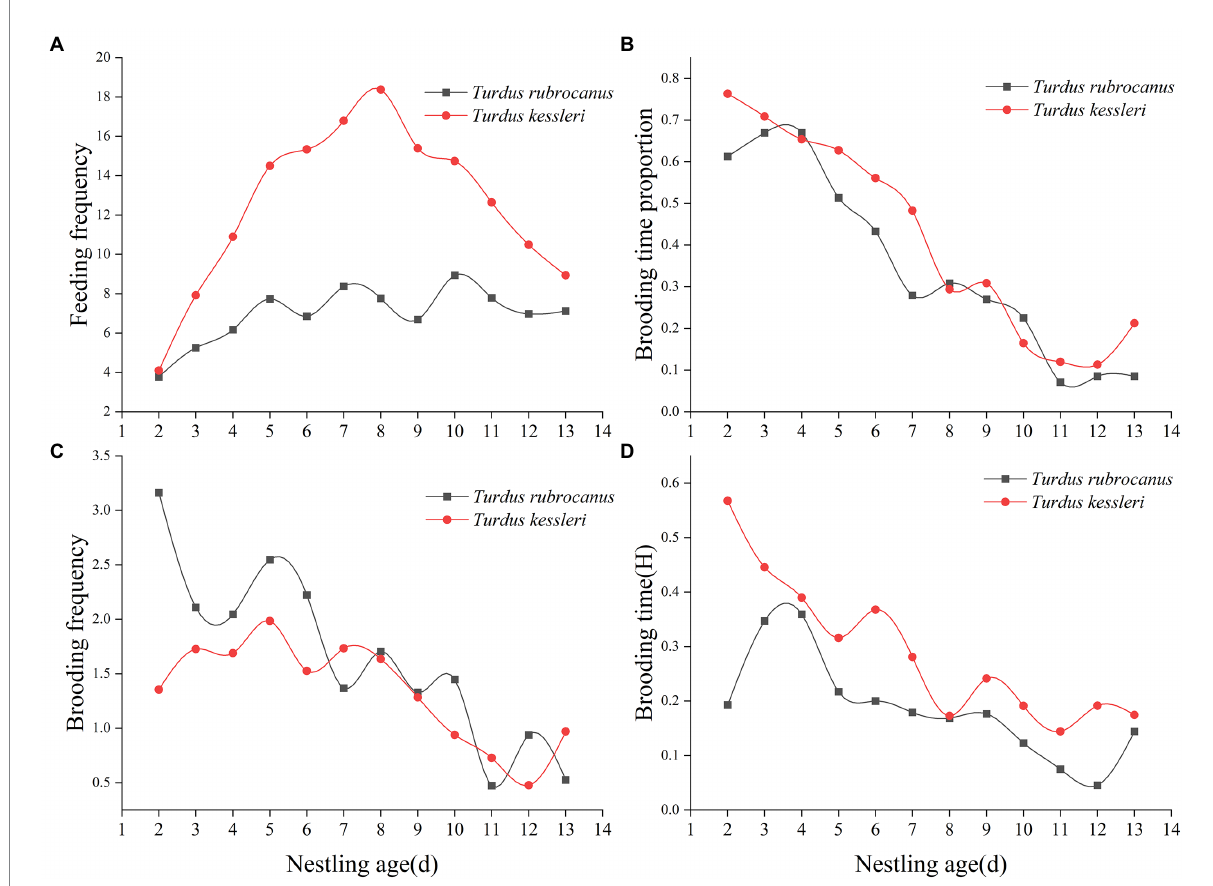
FIGURE 3 (A) Average feeding times per hour of two kinds of thrush in daily monitoring time. (B) The proportion of nesting time of female birds of the two thrush species were monitored daily. (C) The average number of times that two thrushes warmed their nestling per hour during daily monitoring. (D) The average warming time per hour of two thrush species was monitored